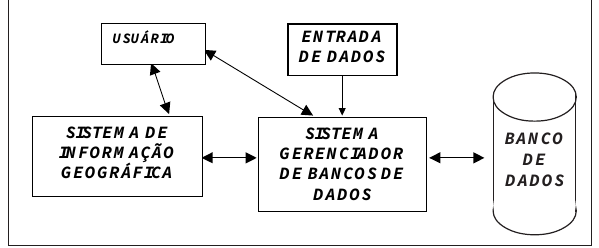
Figura 1. Arquitetura de software do